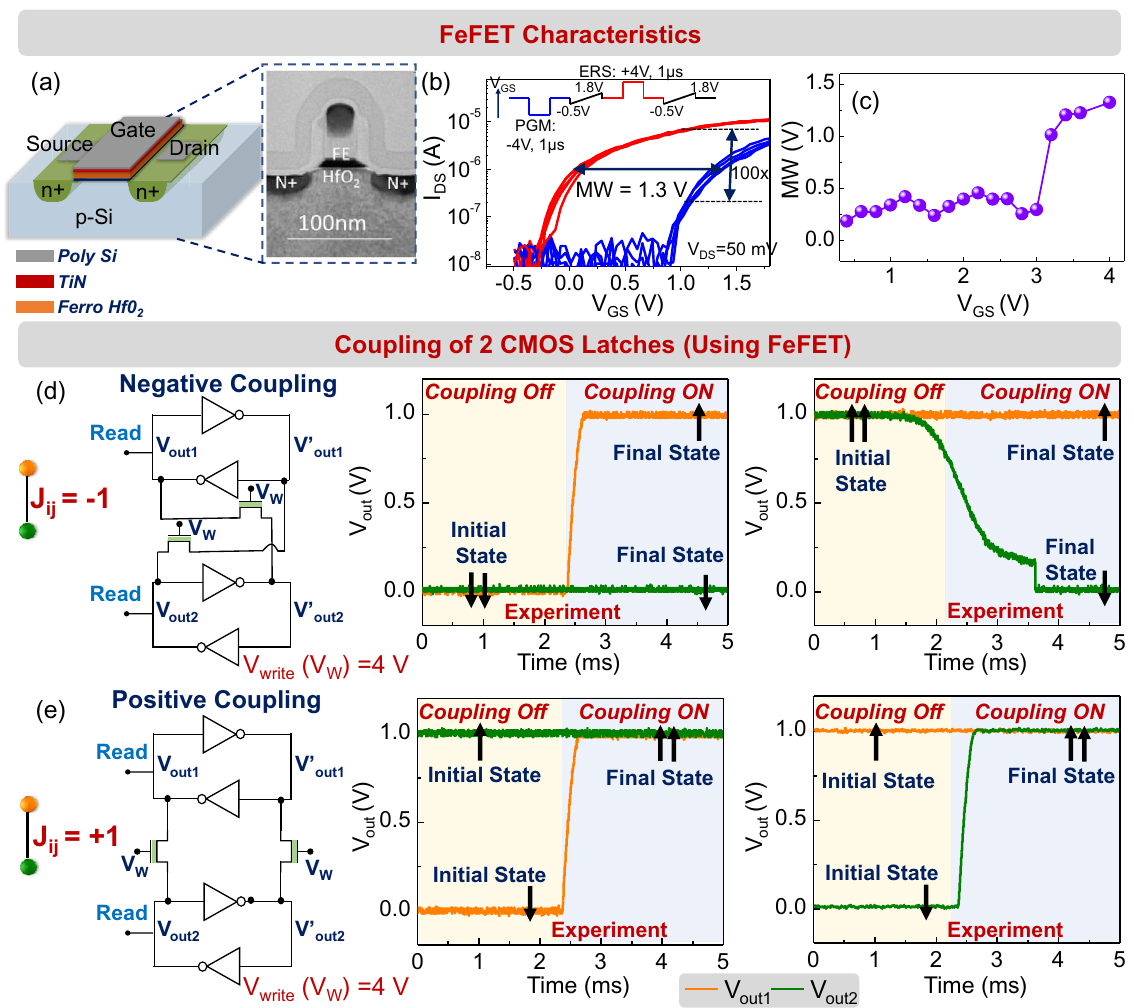
Figure 4. FeFET coupled CMOS latches. ( a ) Schematic and TEM cross-section 50 of a 28 nm high-κ metal gate FeFET device. ( b ) I DS –V GS characteristics of the FeFET (W/L = 0.5/0.5 µm) after program and erase pulses. ( c ) Evolution of memory window (MW) as a function of write voltage (V GS ). FeFET coupled two-latch system settles ( d ) out-of-phase and ( e ) in-phase when the coupling is negative (J ij = − 1) and positive (J ij = + 1),